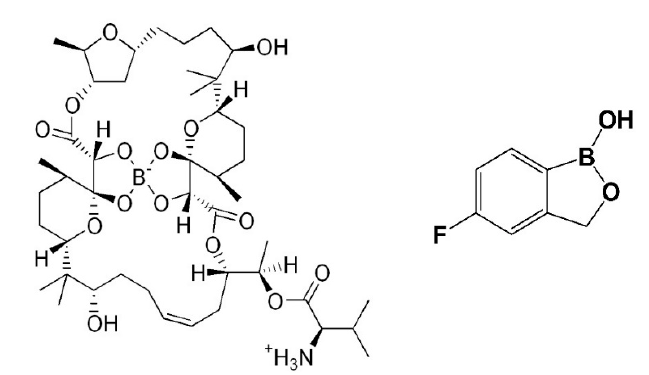
Figure 3. Chemical structures of boromycine ( left ) and tavaborole ( right ).